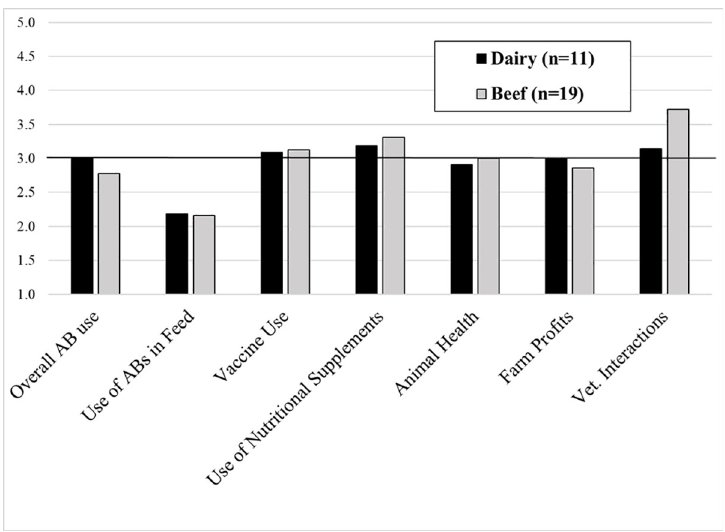
Fig 2. Impact of VFD on subset of Ohio dairy and beef operations using fed antibiotics prior to the VFD. Mean score for impact on various aspects of farm management and performance. Responses to 1–5 Likert Scale in which 1 = Decrease a lot, 2 = Decrease a little, 3 = No Change, 4 = Increase a little, 5 = Increase a lot. Horizontal line represents no reported